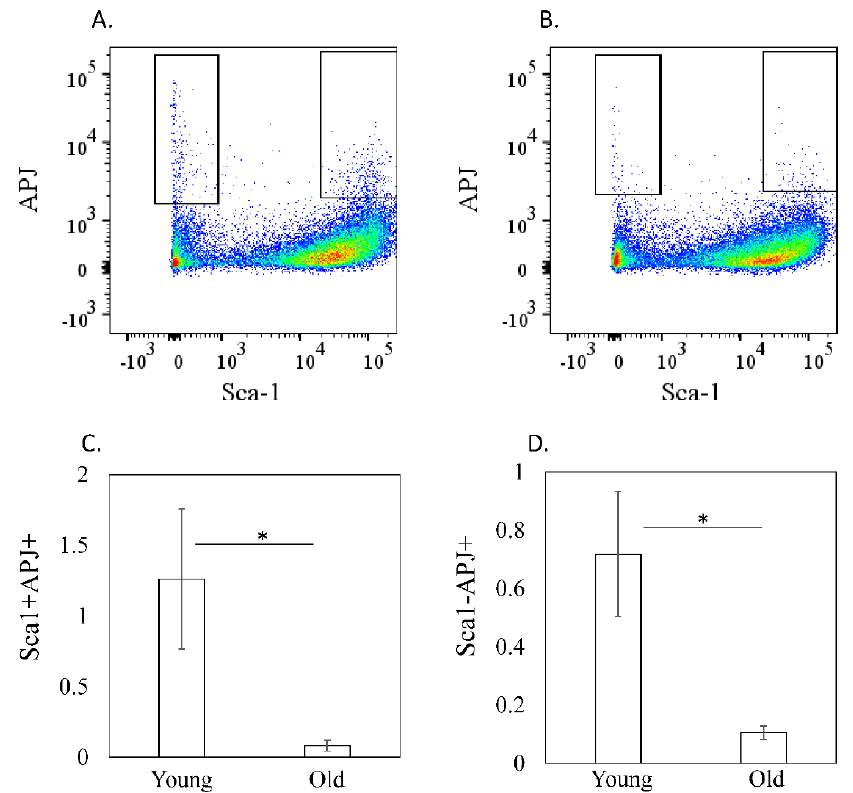
Figure 3. APJ − positive cells in the quadriceps femoris. ( A , B ) Dot plot analysis of CD45-negative myogenic cells. X -axis, Sca-1; Y -axis, APJ. ( C , D ) Ratio of APJ-positive cells among CD45-negative/Sca1-negative cells © and CD45-negative/Sca1-positive cells ( D ) in young (3-month-old) and old (24-month-old) mice. Significant reduction in APJ-positive cells was found in Sca1+ ( p = 0.016) and Sca1 − cells ( p = 0.016). Data are expressed as the mean ± standard deviation (SD). Asterisks indicate p < 0.05 ( Mann–Whitney U test).